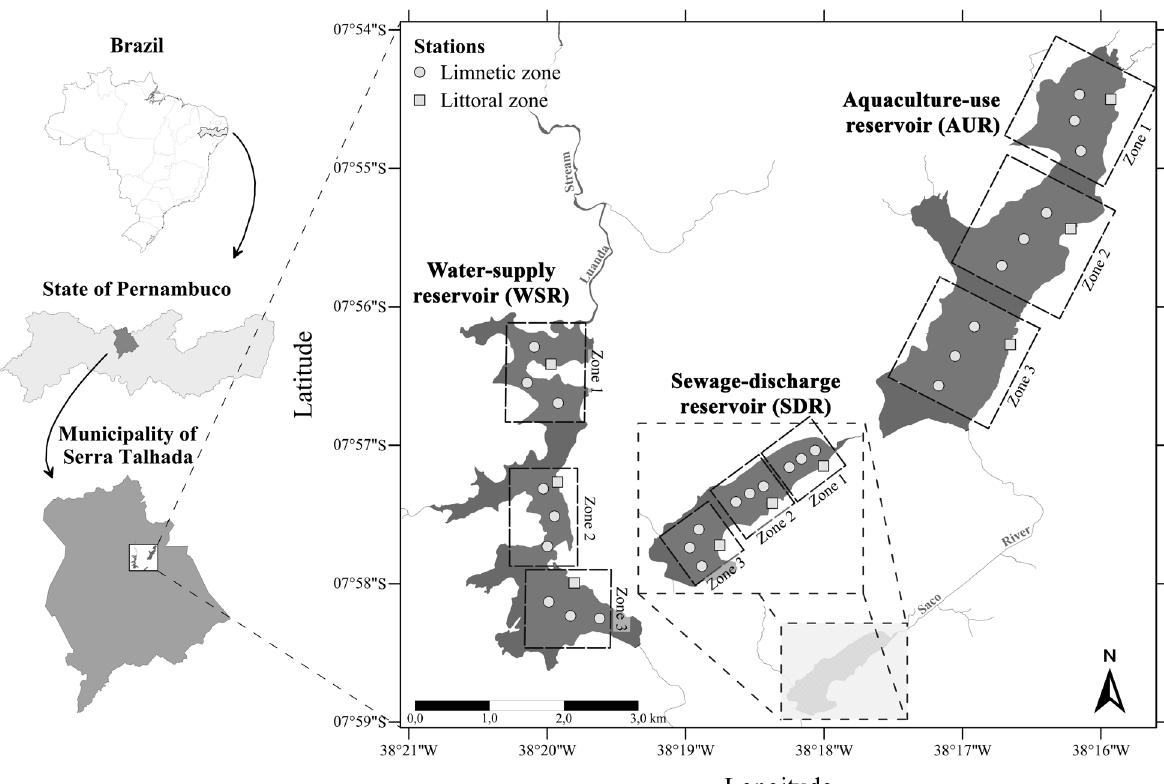
Figure 1. Distribution and location of the sampling stations in three reservoirs in the neotropical semiarid ecosystem (Pernambuco, Brazil): Cachoeira II (water supply reservoir—WSR), Borborema (sewage discharge reservoir—SDR) and Saco I (aquaculture-use